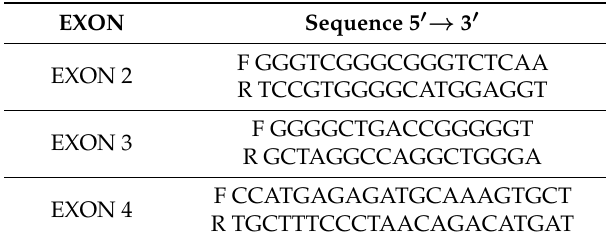
Table 2. The nucleotide sequences of primers used in PCR and sequencing [13]. EXON Sequence 5 (cid:48) → 3